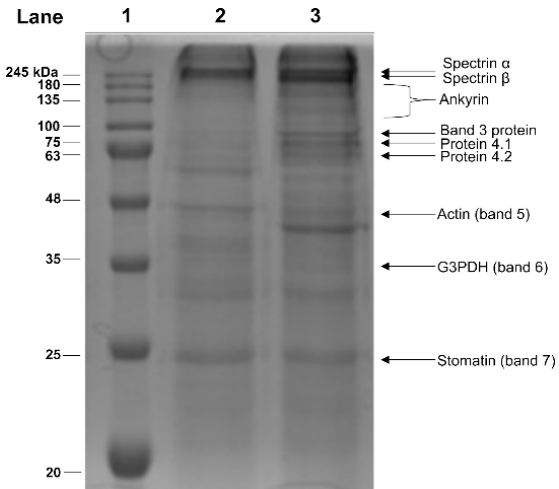
Figure 4. SDS-PAGE analysis of the membrane fraction from Hg-treated human RBC. Intact RBC were exposed in vitro for 4 h to 1 µM HgCl 2 and the membrane fractions analysed by SDS-PAGE. MW markers (lane 1); sample from untreated (lane 2) and Hg-treated RBC (lane 3).